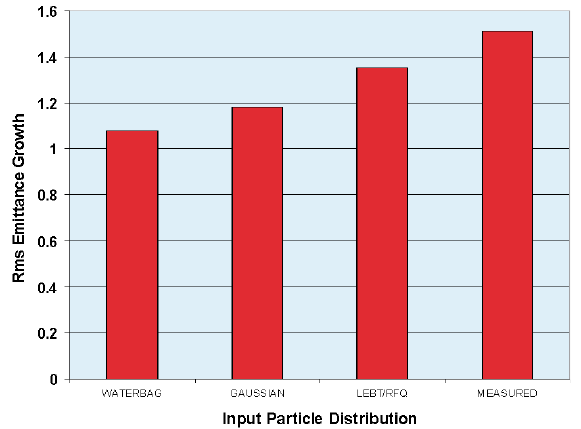
FIG. 12. Final rms-emittance growth for the double- Gaussian distribution as a function of the relative heights of the two Gaussian distributions for a fixed ratio of the rms widths equal to